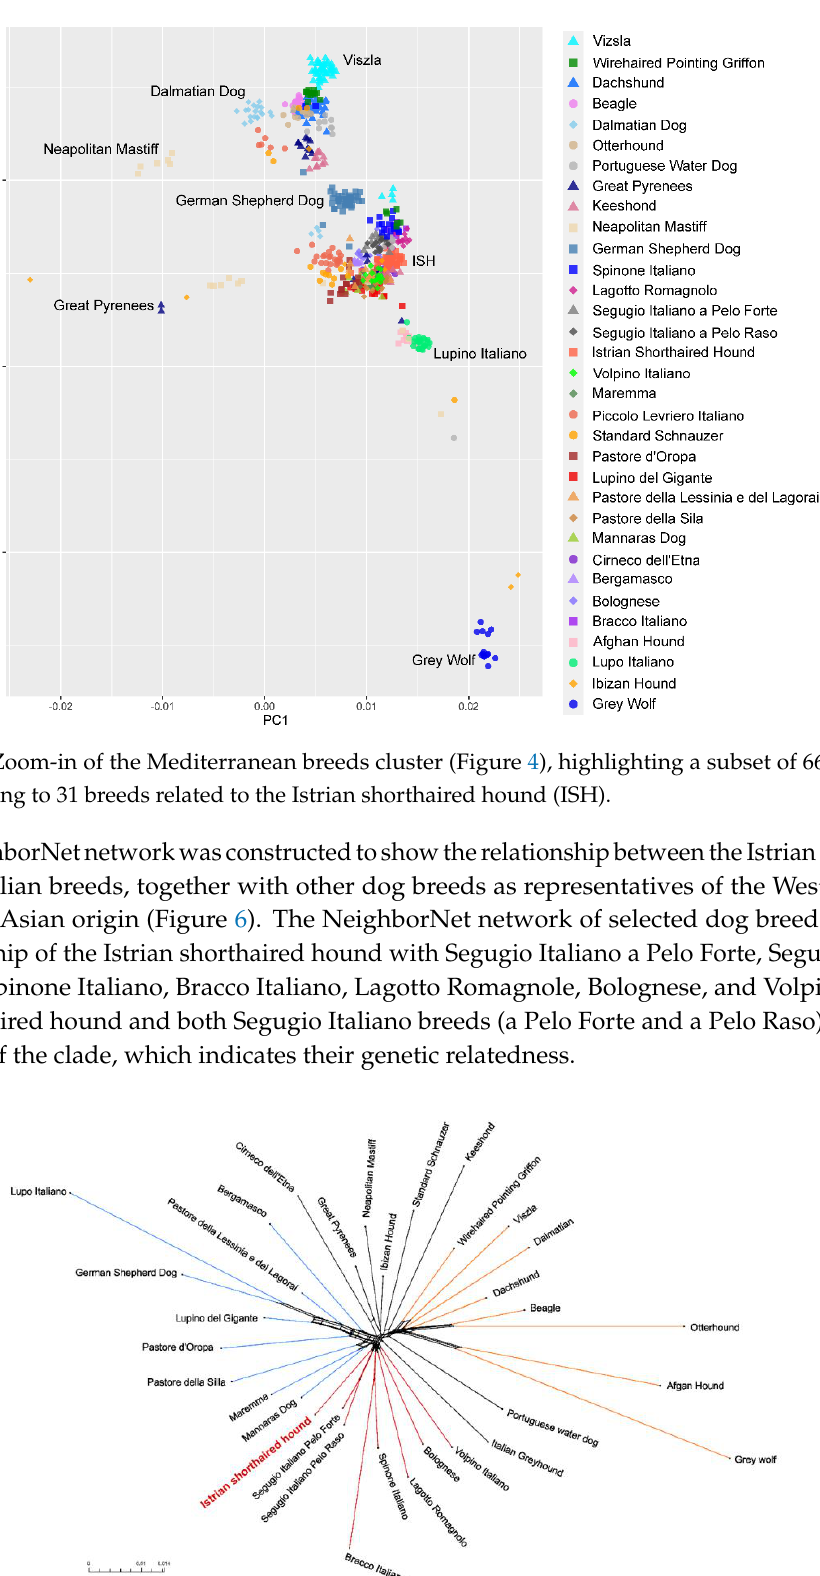
Figure 6. NeighborNet network computed from pairwise Nei distances between Istrian shorthaired hound, 31 other dog breeds, and Grey wolf.